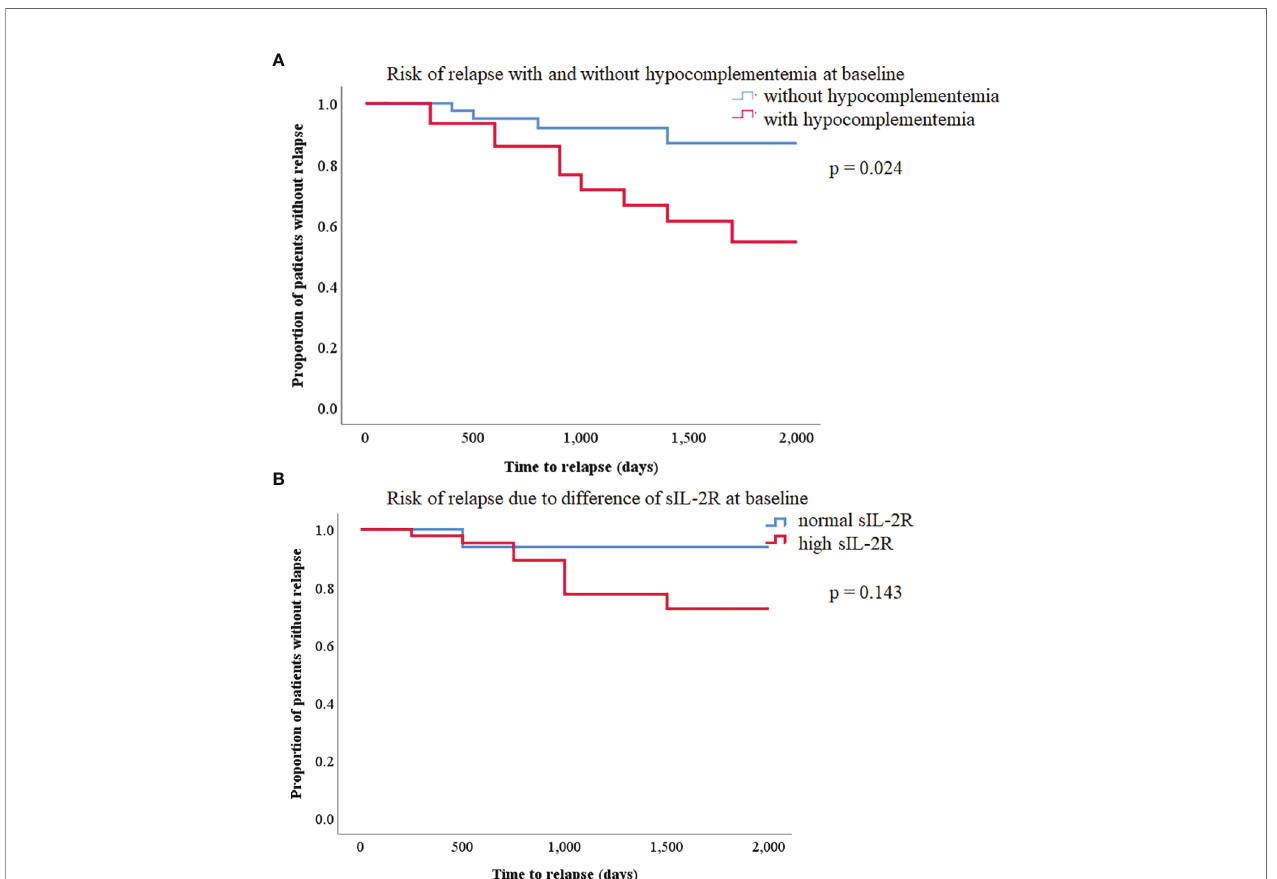
FIGURE 3 | (A) Kaplan – Meier curves of relapse-free survival in patients with immunoglobulin G4-related disease (IgG4-RD) with or without hypocomplementemia. There was a statistically signi fi cant difference between the two curves (log-rank test, p = 0.024). (B) Kaplan – Meier curves of relapse-free survival between high and normal soluble IL-2R in patients with IgG4-RD. There was no signi fi cant difference between the two curves (log-rank test, p = 0.143).